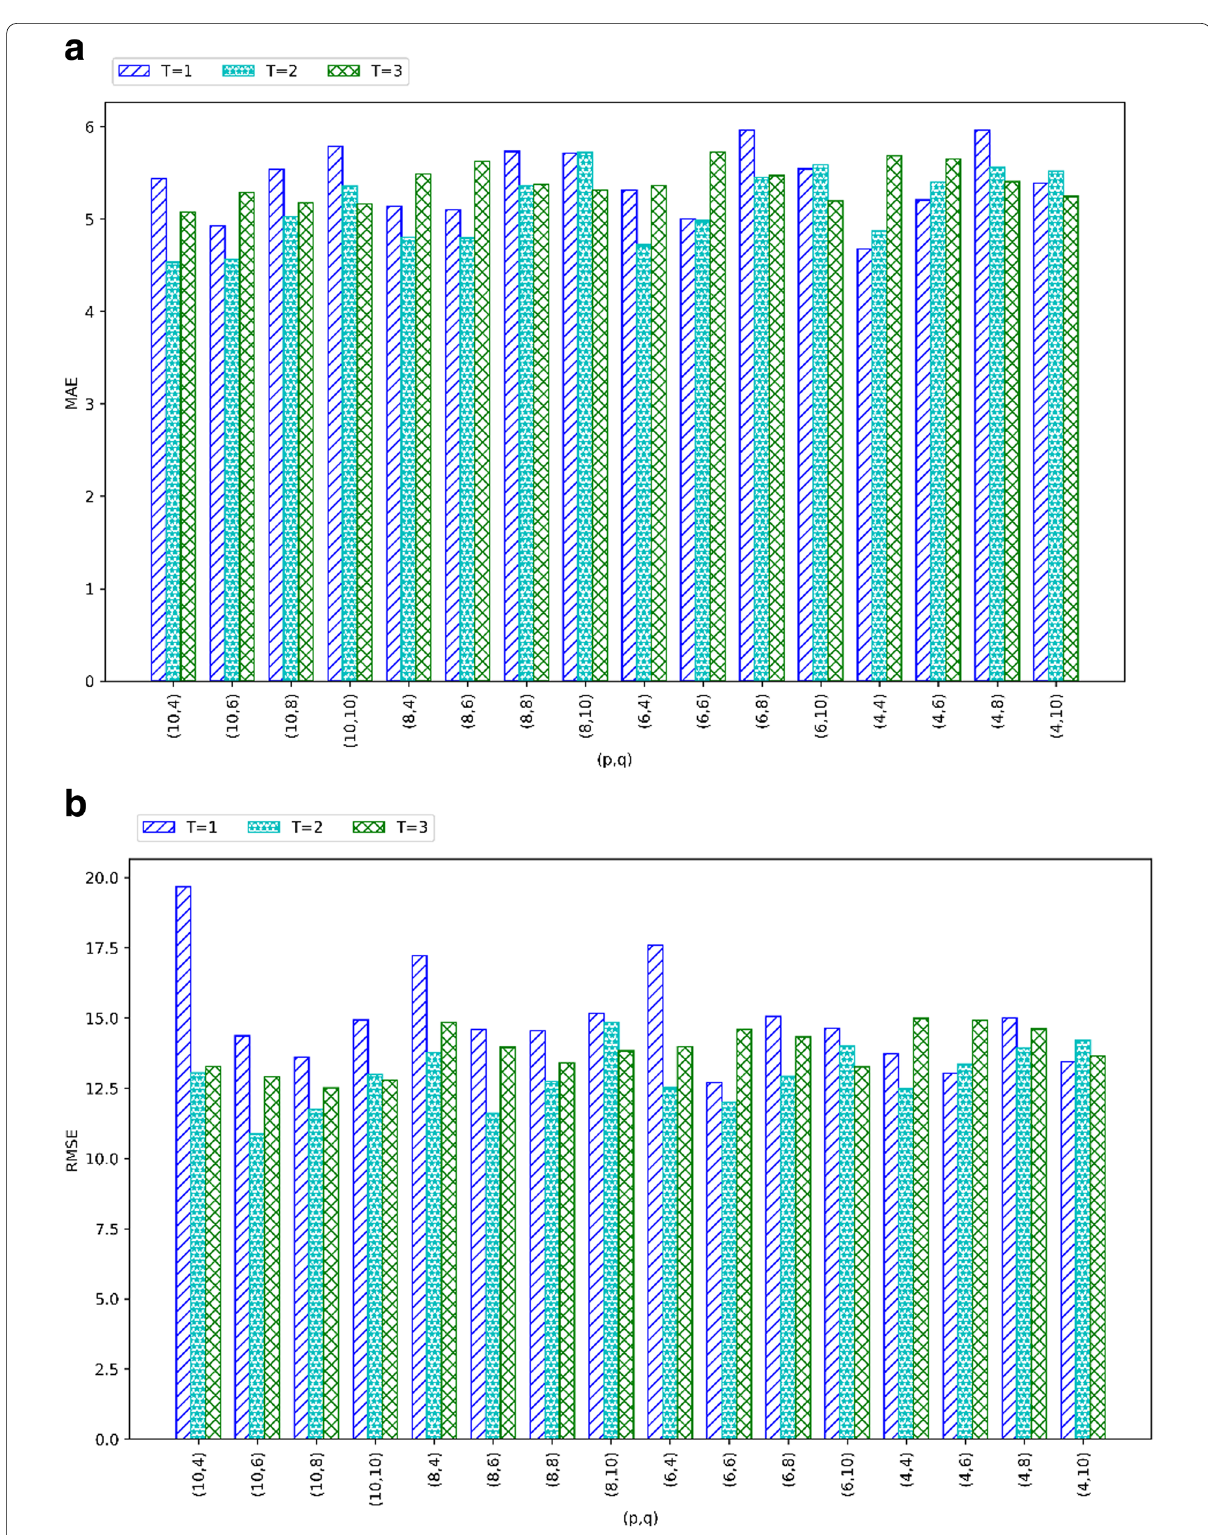
Fig. 4 Anomaly detection accuracy of Ano-Det w.r.t. ( p , q , T